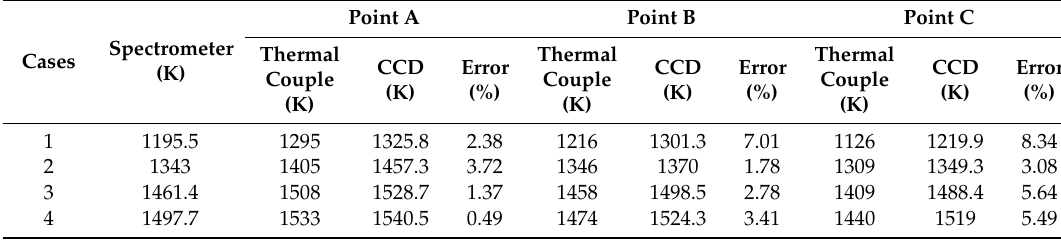
Table 3. Comparison of the temperature measurement